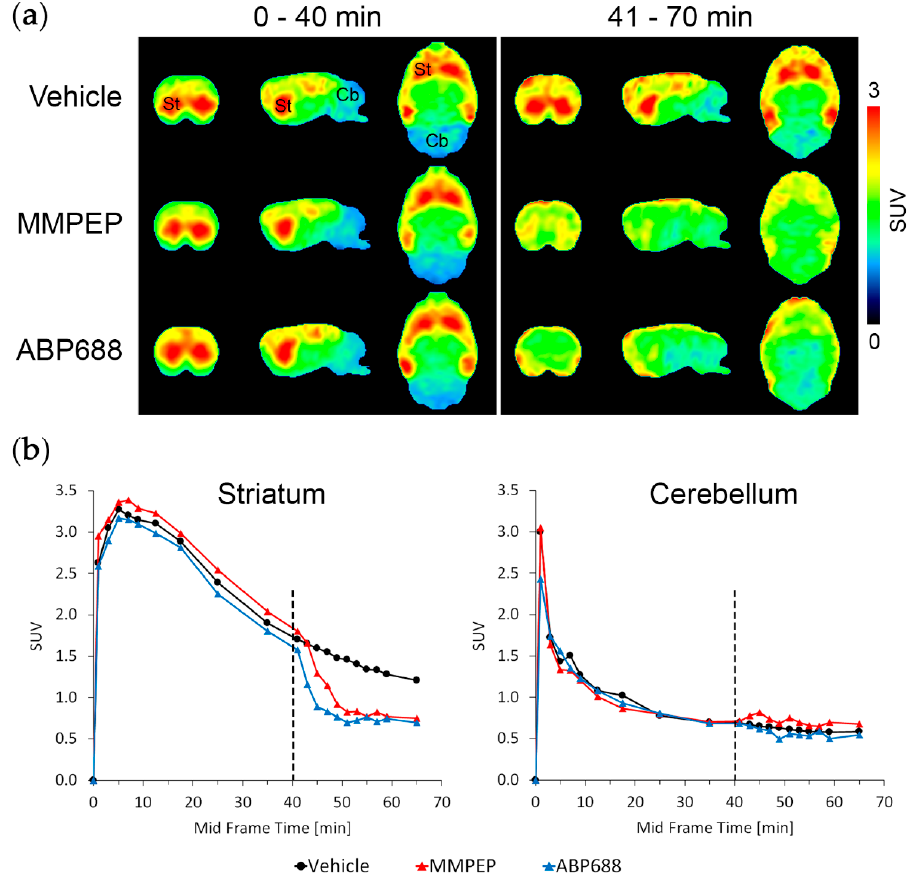
Figure 4. In vivo displacement study of [ 18 F]PSS232 with either vehicle ( n = 1; 1:1 PEG200/aqua ad inject), 1 mg/kg MMPEP ( n = 1) or 1 mg/kg ABP688 ( n = 1) at 40 min post radiotracer injection. ( a ) [ 18 F]PSS232 PET images of rat brains averaged from 0–40 and 41–70 min after radiotracer injection.